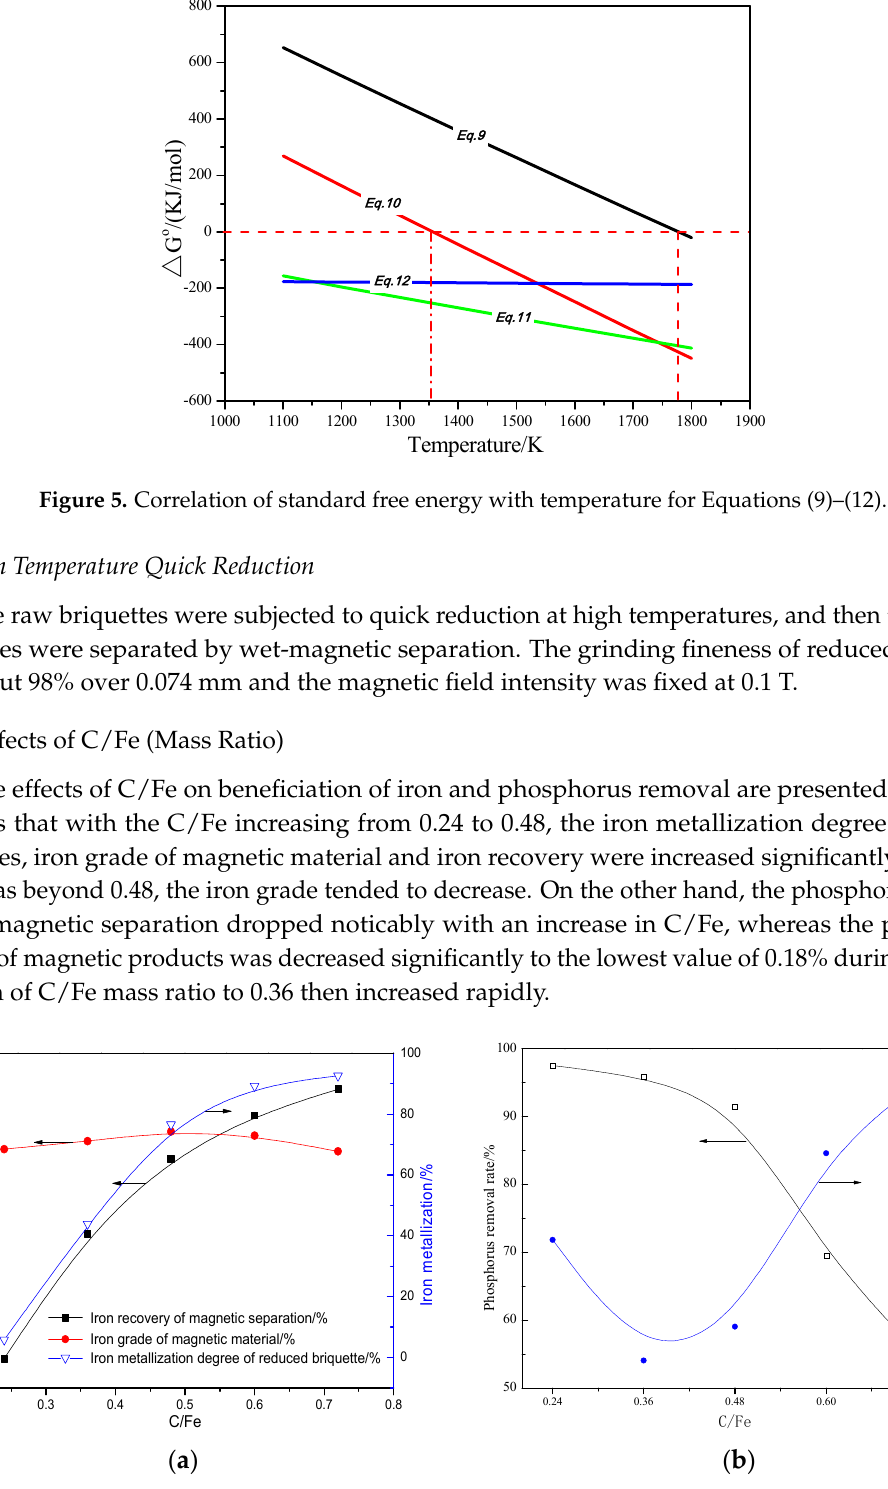
Figure 6. Effects of C/Fe (mass ratio) on beneficiation of iron and phosphorus removal rate (2.4 basicity, ore blended with 10% sodium sulfate and reducing at 1350 °C for 15 min). ( a ) Effect of C/Fe on iron recovery; ( b ) effect of C/Fe on phosphorus removal.